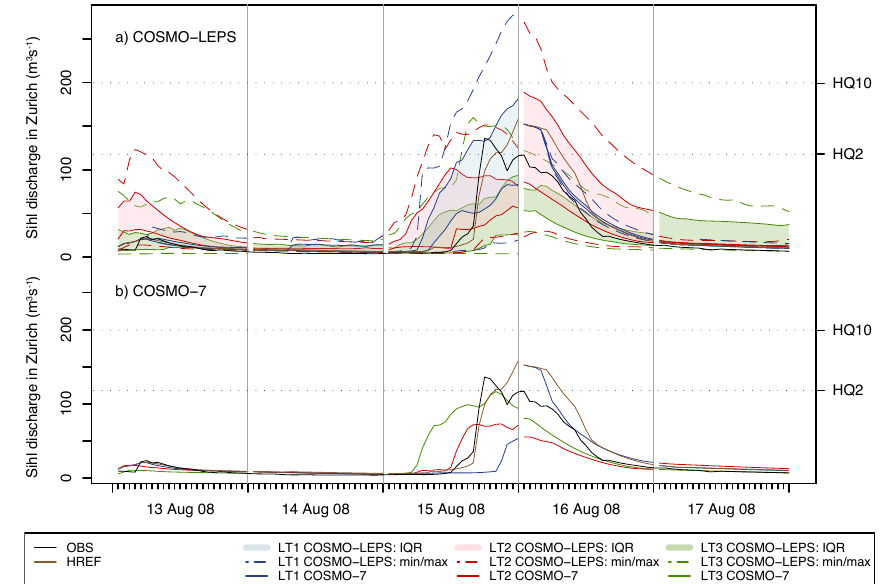
Fig. 9. Continuous persistence plots as in Fig. 8, but centred on the 15 August 2008